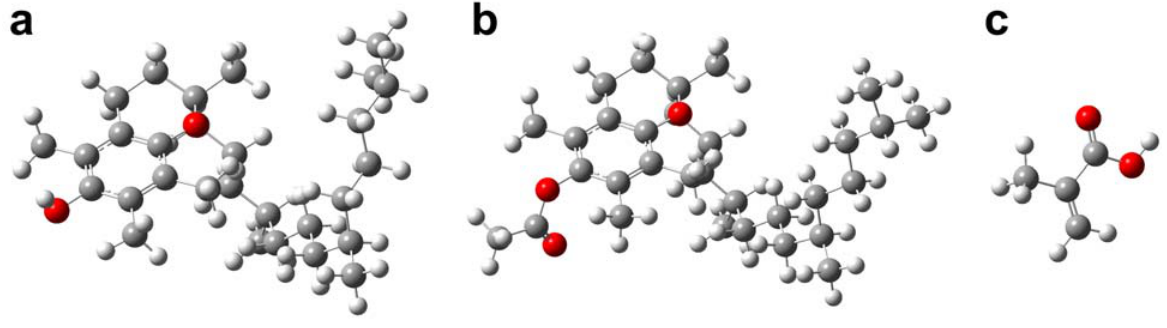
Figure 2. Molecular structures of tocopherol (a) and tocopherol acetate (b) and methacrylic acid